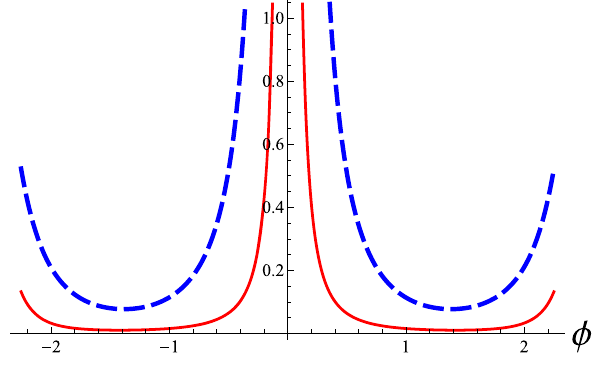
Fig. 3 The determinant of the matrix γ M IJ (the solid red line) and γ M ( R ) = R + γ R 11 (the dashed blue line) for f